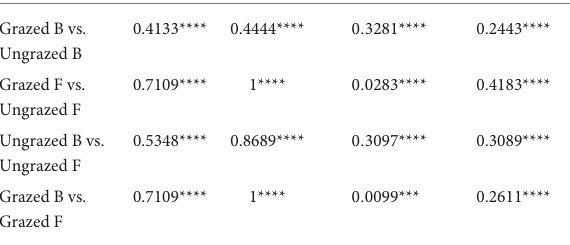
TABLE 1 Results of the Kolmogorov–Smirnov test comparing bootstrapped node attributes of networks under grazed and ungrazed.